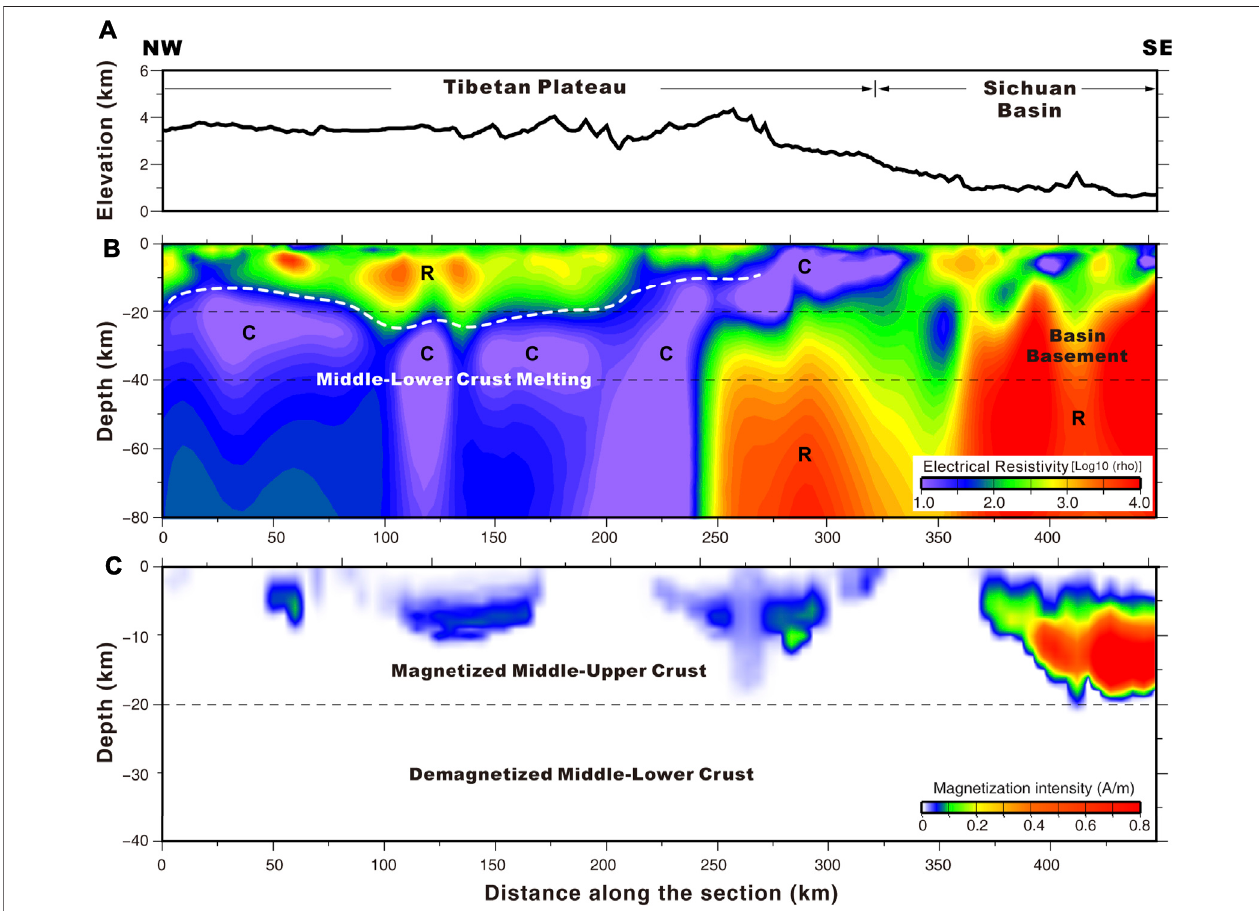
FIGURE 7 | Line two magnetotelluric survey magnetization distribution pro fi le: (A) altitude (B) electrical resistivity and (C) magnetization distribution.